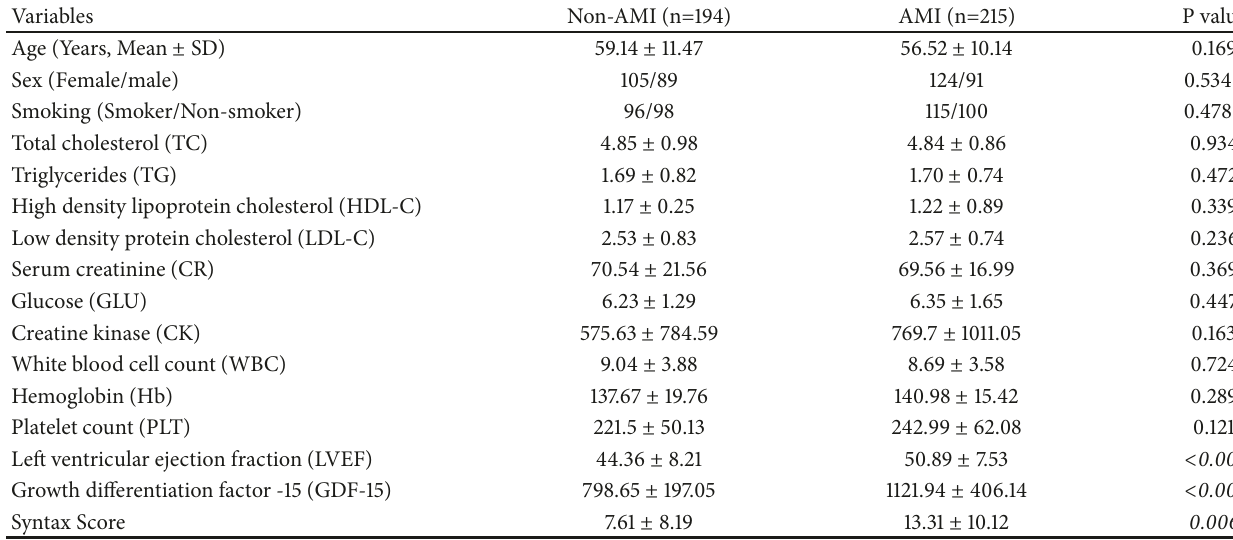
Table 2: Comparison characterization between patients with non-AMI and AMI.